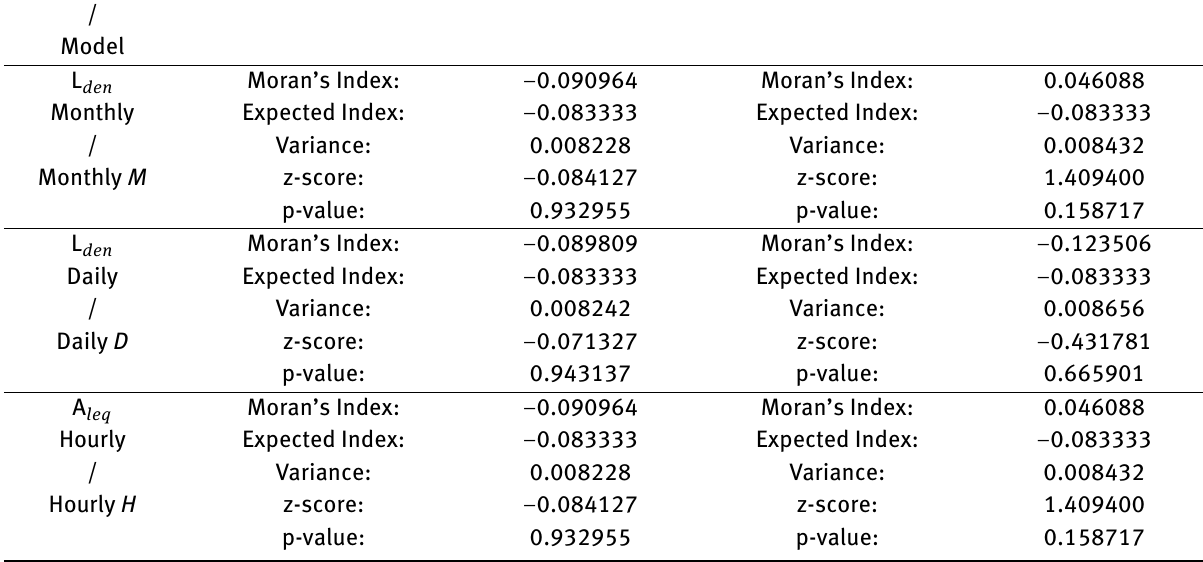
Supplementary Table 5: Global Moran’s